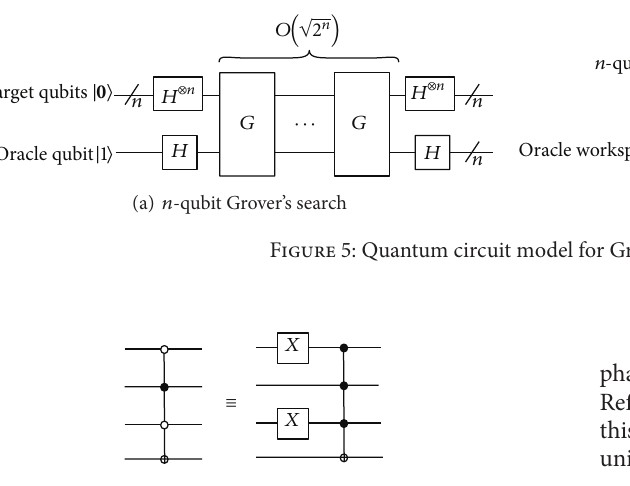
Figure 6: Oracle circuit for recognizing binary string